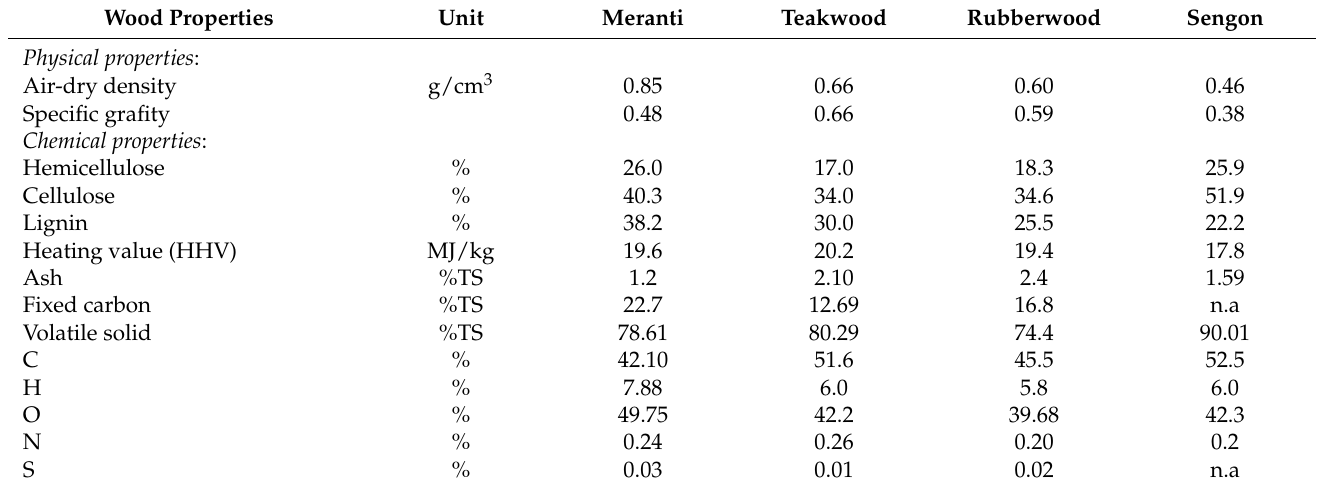
Table 2. Characteristic of wood specific to Indonesia (meranti, teak, rubberwood,